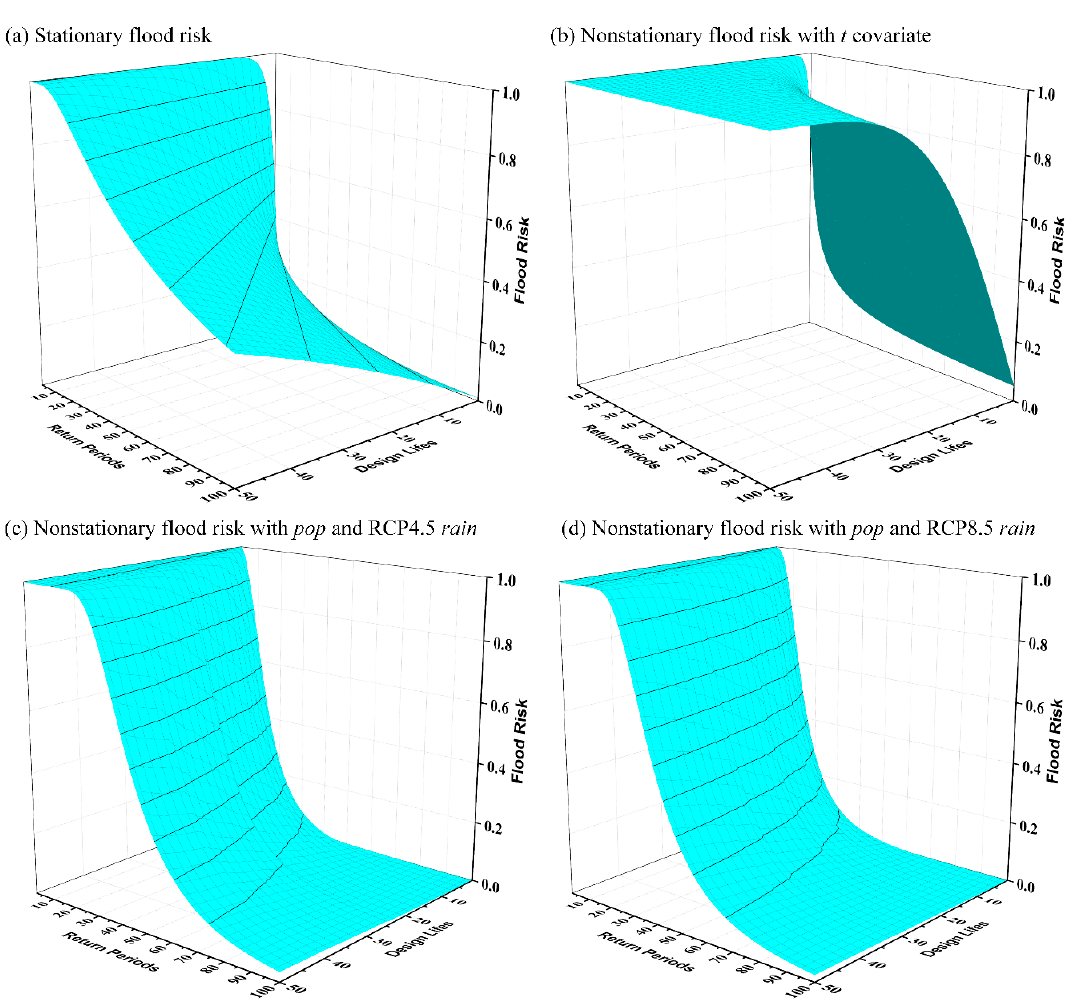
Figure 11. Stationary and nonstationary flood hazard of Dahuangjiangkou station corresponding to return periods changing from 2 to 100, and design lifes changing from 1 to 50. ( a ) stationary flood hazard corresponding to design flood z q ; ( b ) nonstationary flood hazard calculated by nonstationary model with time covariate; ( c , d ) are nonstationary flood hazards calculated by nonstationary models with pop and rain covariates under RCP 4.5 and RCP 8.5 scenarios, respectively.